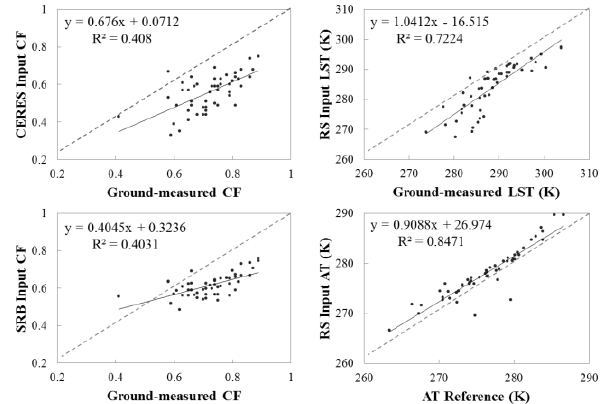
Figure 7. Multi-year mean of LST, AT and CF derived by satellite and site observations at 43